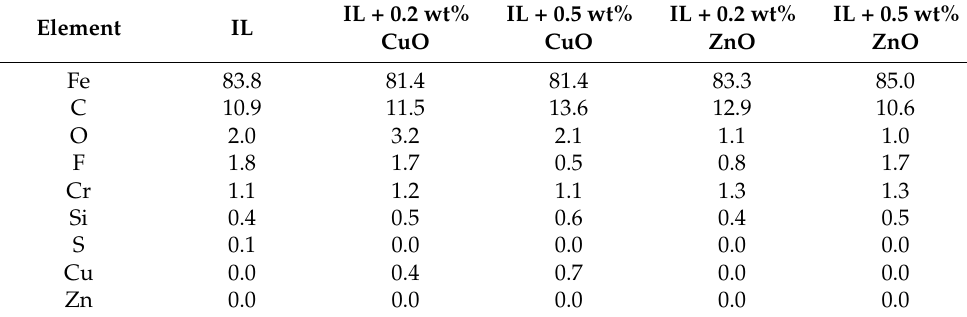
Table 4. Distribution of chemical components on